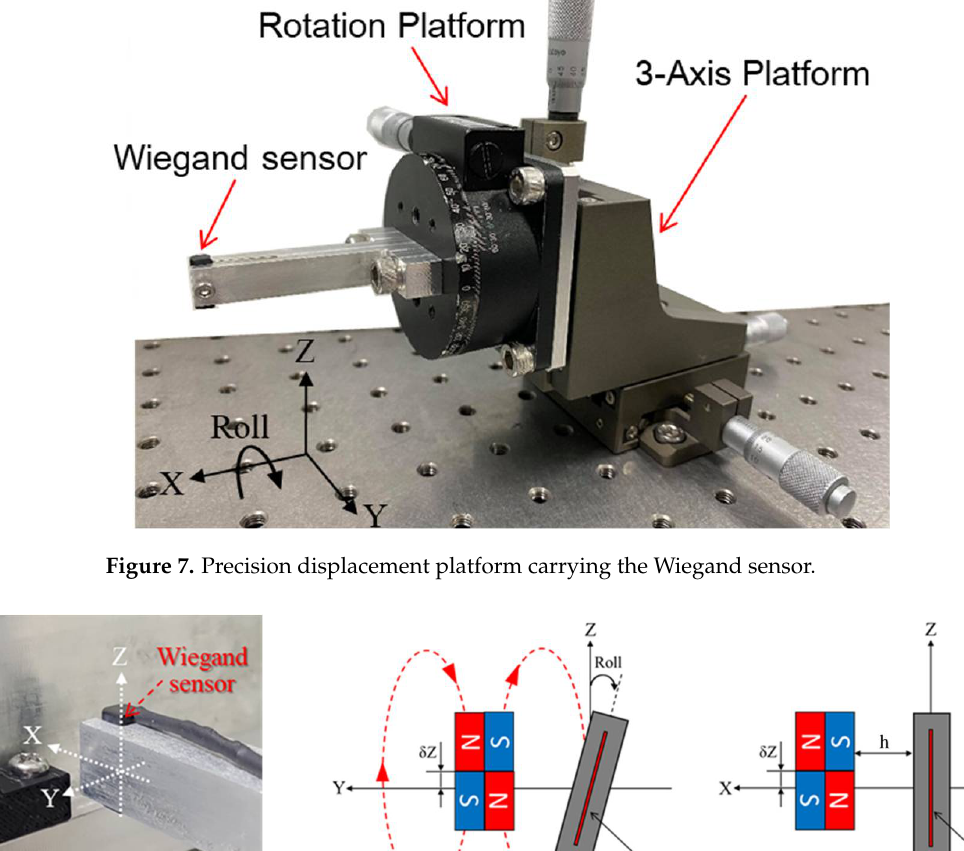
Figure 6. Schematic drawing of the comparator circuit.